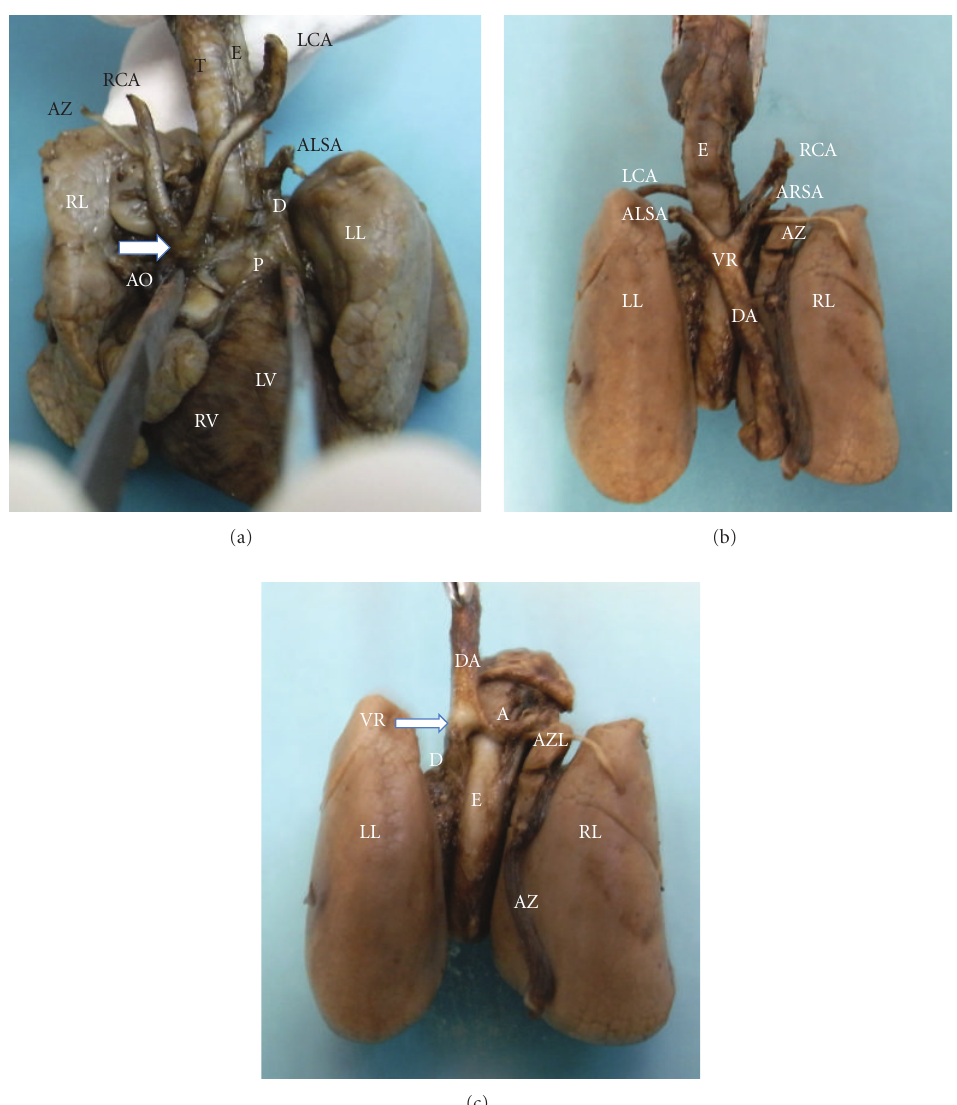
Figure 4: (a) Anterior view of the mediastinum. The pulmonary artery (P) and ductus arteriosus (D) are seen crossing over the left bronchus towards a right-sided descending aorta. An aberrant left subclavian artery (ALSA) is seen branching at the union between the ductus and the aorta. Both left and right carotid arteries (RCA/LCA) branch from the aortic arch (AO) anteriorly to the trachea in a V-shape set up. We could not confirm the presence of a diverticulum of Kommerel at the origin of the left subclavian artery. An aberrant azygos vein (AZ) is seen separating the upper lobe of the right lung forming an azygos lobe. RL: right lung, LL: left lung, T: trachea, E: esophagus. (b) Posterior view of the mediastinum. Aberrant left and right subclavian arteries (ALSA/ARSA) are seen branching from the vascular ring (VR) in the union between the ductus and the aorta. Both left and right carotid arteries (LCA/RCA) are seen coming from the anterior mediastinum after branching from the aortic arch. An aberrant azygos vein (AZ) is seen separating the upper lobe of the right lung forming an azygos lobe. RL: right lung, LL: left lung, E: esophagus, DA: descending aorta. (c) Posterior view of the mediastinum. The descending aorta has been moved upwards in order to see the vascular ring (VR) (arrow). The ductus arteriosus (D) is seen crossing over the left bronchus joining the descending aorta (DA). A right aortic arch (A) is seen surrounding the esophagus (E). An aberrant azygos vein (AZ) was seen separating the upper lobe of the right lung forming an azygos lobe (AZL). RL: right lung, LL: left lung, E: esophagus.